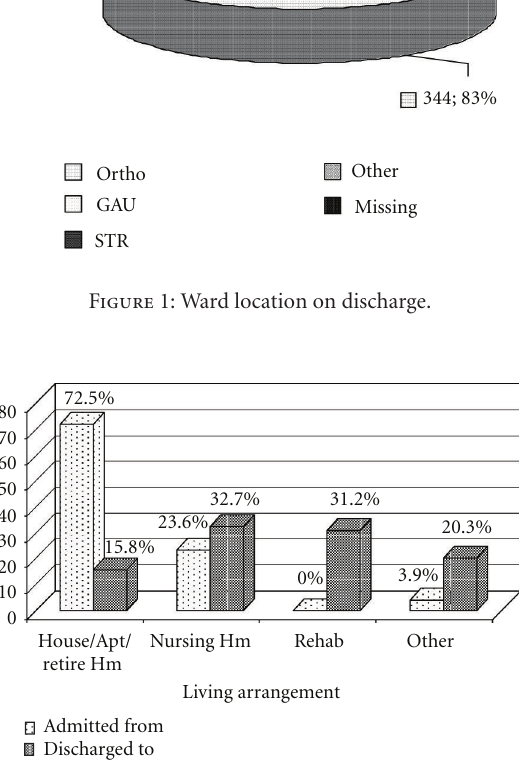
Figure 2: Patient living arrangement at admission and discharge.